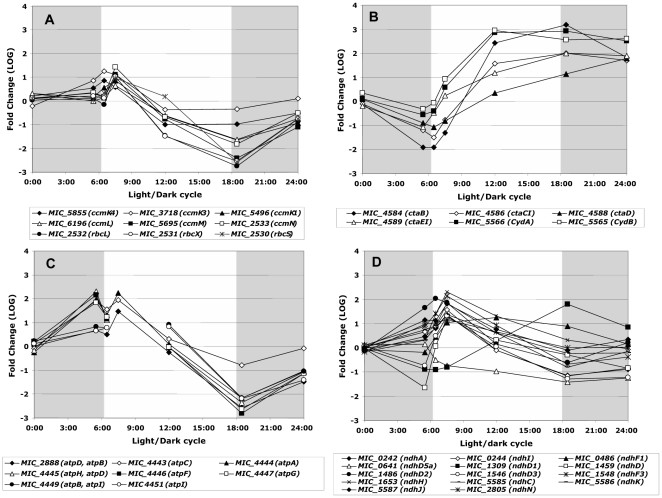
Significant variations in the transcript abundance of genes involved in carbon transport and energy metabolism during the light/dark cycle.
A. Carbon dioxide concentrating mechanism genes (ccm genes) and ribulose bisphosphate carboxylase genes (rbc genes). B. Respiratory terminal oxidases, cytochrome c oxidases and protoheme IX farnesyltransferase genes (cta and cyd genes). C. ATP synthase genes (atp genes). D. NADH dehydrogenase genes (ndh genes). The gray shaded part of the figure represents the dark period of the light/dark cycle.